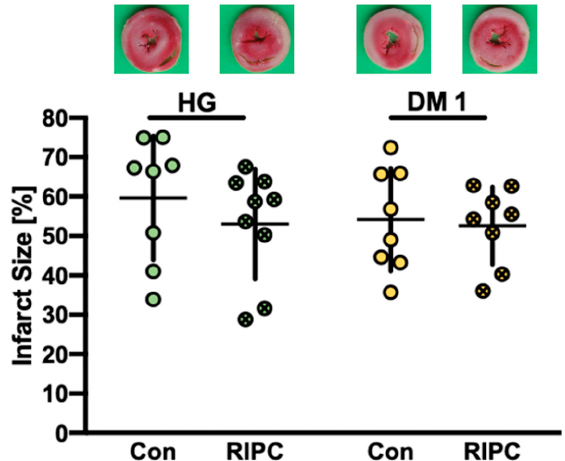
Figure 2. Infarct size measurement of part 2, including representative photos of each group. Con = control; RIPC = remote ischemic preconditioning; HG = hyperglycemia; DM1 = diabetes mellitus type 1. Data are presented as mean ± SD.